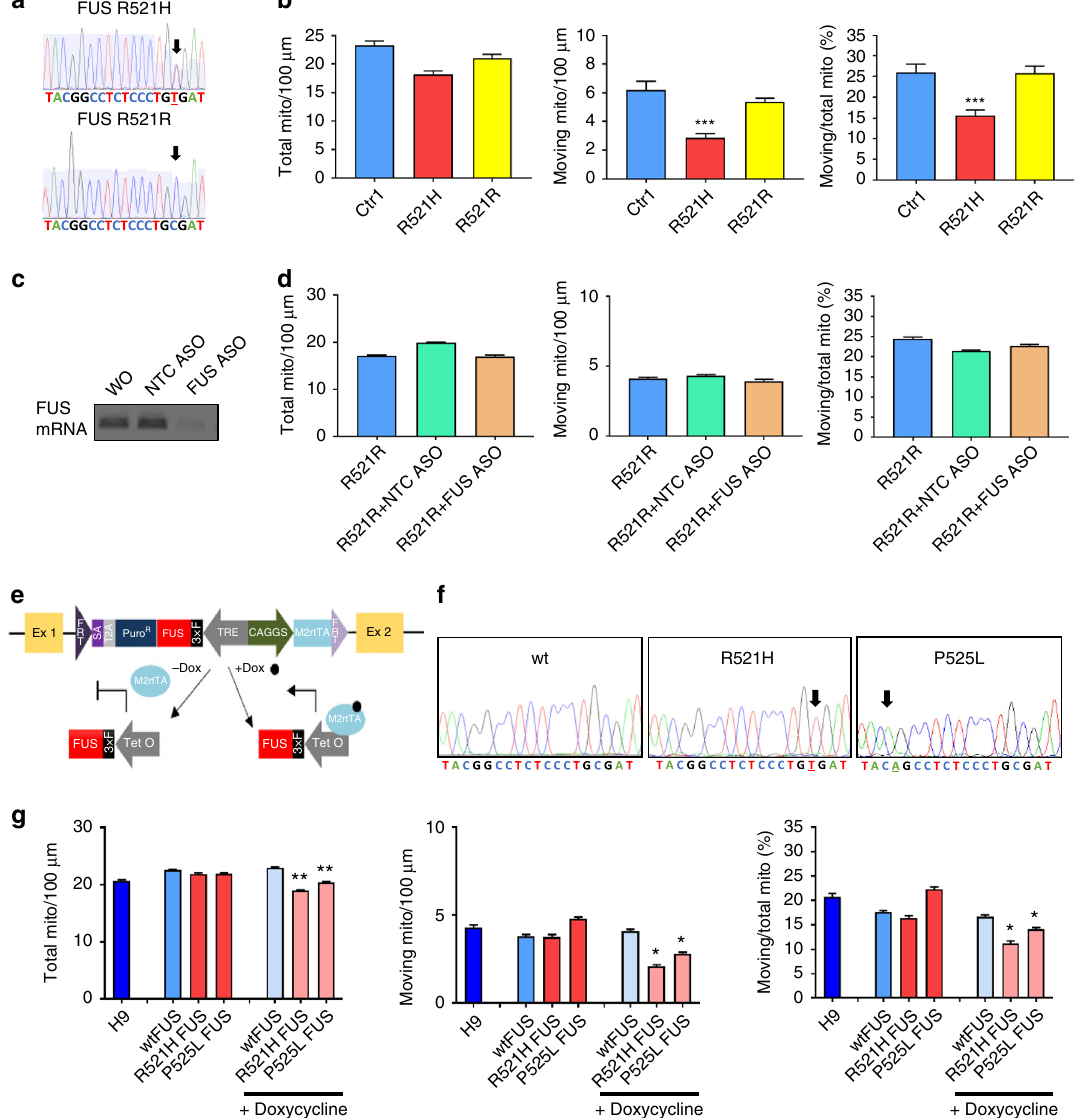
Fig. 4 Axonal transport defects are caused by mutant FUS. a Genomic DNA sequencing showing the nucleotide change (C to T) in the R521H patient line (labeled as FUS R521H) and the homozygous nucleotide C in the corrected isogenic control iPSC line (labeled as FUS R521R). b Quanti fi cations of total mitochondria, moving mitochondria, and ratio between moving to total mitochondria normalized to a neurite length of 100 µ m during 200 s in motor neurons derived from a control iPSC line, from a patient iPSC line with the R521H mutation and its isogenic control measured at 4 weeks after plating. ( n = 11, n = 14, n = 12, respectively, for wildtype, mutant, and isogenic control, mean ± SEM; one-way ANOVA with post-hoc Tukey ’ s test). c RT-PCR validation of ASO knockdown of FUS in motor neurons. d Knockdown of FUS did not interfere with total number of mitochondria, moving mitochondria, and mitochondrial transport ef fi ciency. Scrambled ASO was used as a negative control (NTC ASO). n = 20, n = 19, n = 17 for R521R, R521R + NTCASO, R521R + FUS ASO, respectively. Data values represent mean ± SEM. e Schematic diagram of the strategy used for inducible expression of FUS in the AAVS1 site using recombinase-mediated cassette exchange (RMCE) and the targeting vector pZ: F3 ‐ P TetOn-3 × F-FUS-F fl anked by short fl ippase recognition targets (FRTs) in the engineered H9-hESC line. This vector also contains a Tet-On system. Adding doxycycline (Dox) to the medium results in its binding to the M2 tetracycline transactivator (M2rTA) protein. This Dox – M2rtTA complex is capable of binding the Tet operator (TetO), which is part of the tetracycline response element (TRE), to trigger FUS expression. f DNA sequencing showing homozygous wildtype FUS, mutant FUS carrying the R521H or the P525L mutation in the hESC lines that can overexpress FUS. g Calculations of stationary mitochondria, moving mitochondria, ratio of moving to total mitochondria per 100 µ m neurite length during 200 s for motor neurons derived from hESCs at the fourth week after plating. Only overexpression of mutant FUS induces mitochondrial transport defects ( n = 12, n = 15, n = 12, n = 13, n = 14, n = 11, n = 14, respectively, for H9, wtFUS, R521H FUS, P525L FUS, wtFUS + Dox, R521H FUS + Dox, P525L FUS + Dox, mean ± SEM, one-way ANOVA with post-hoc Tukey ’ s test, *, **, *** P values of 0.05, 0.01, and 0.001,